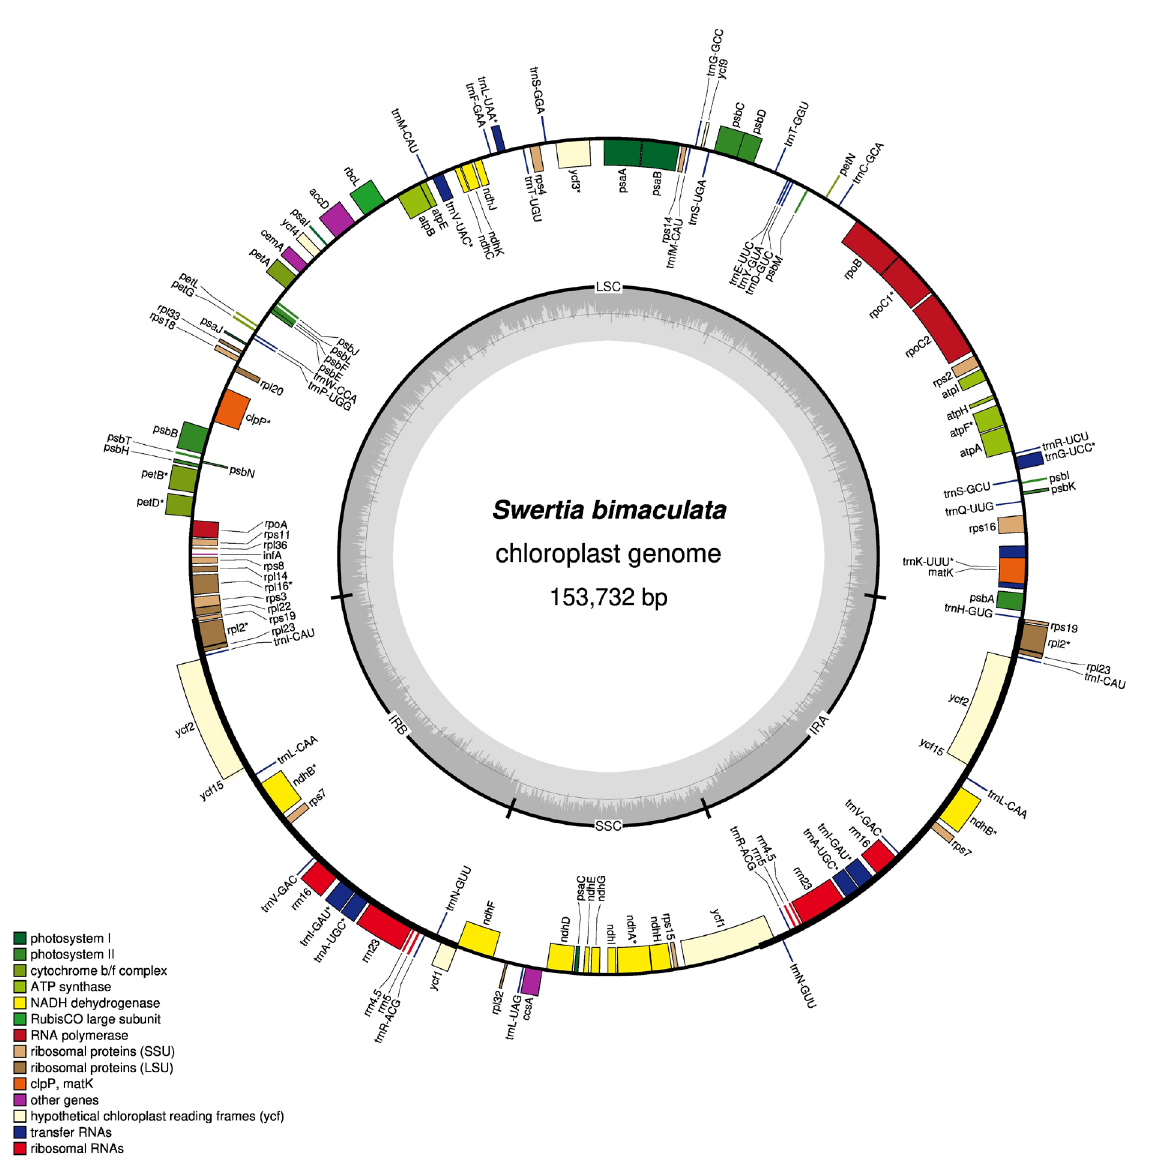
Figure 1 – Gene map of the Swertia bimaculata (MW344293) chloroplast genome. The translation of genes outside the outer circle occurs in a counter- clockwise direction, while the translation of genes inside occurs in a clockwise direction. The dark and light gray colors in the inner circle represent GC and AT content, respectively. Different functional gene groups are highlighted by different